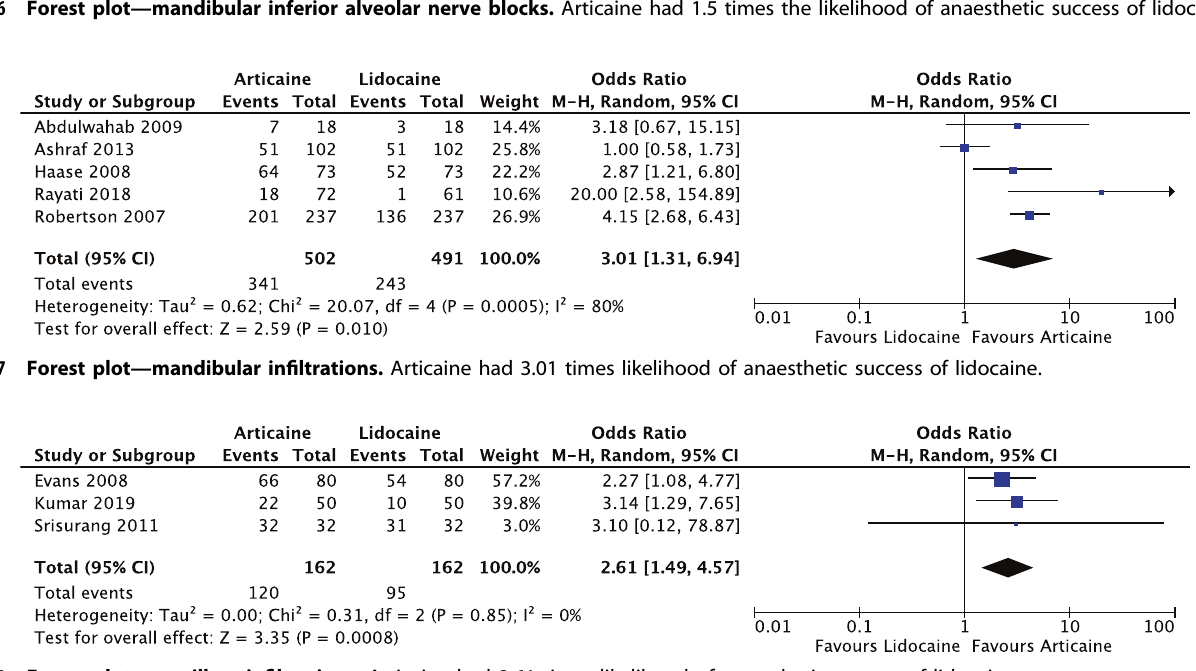
Fig. 8 Forest plot — maxillary in fi ltrations. Articaine had 2.61 times likelihood of anaesthetic success of lidocaine. more likely in the mandible ( P = 0.0002) and 2.61 times more likely in the maxilla ( P = 0.0008). Pulp status . Meta-analysis was performed for the differences in pre-intervention pulp status between symptomatic and asympto- matic teeth. For asymptomatic teeth, articaine had 2.31 times higher likelihood of anaesthesia success of lidocaine with BDJ Open (2021)